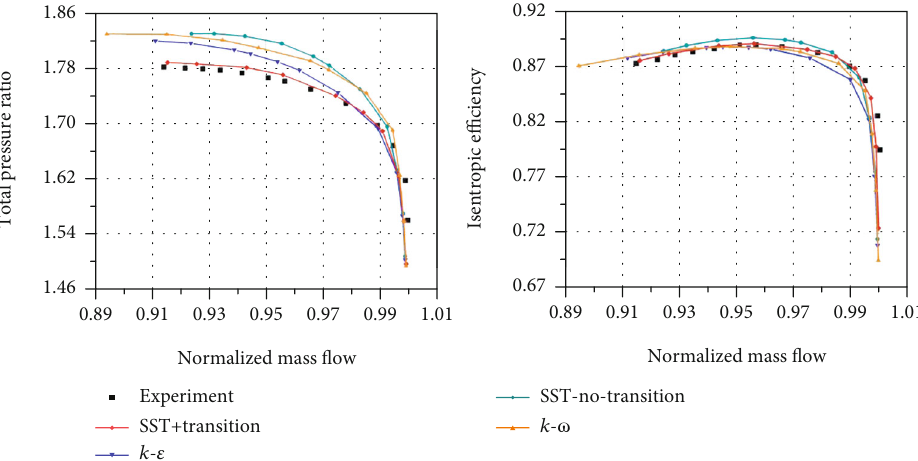
Figure 4: The compressor aerodynamic performance calculated by di ff erent turbulence